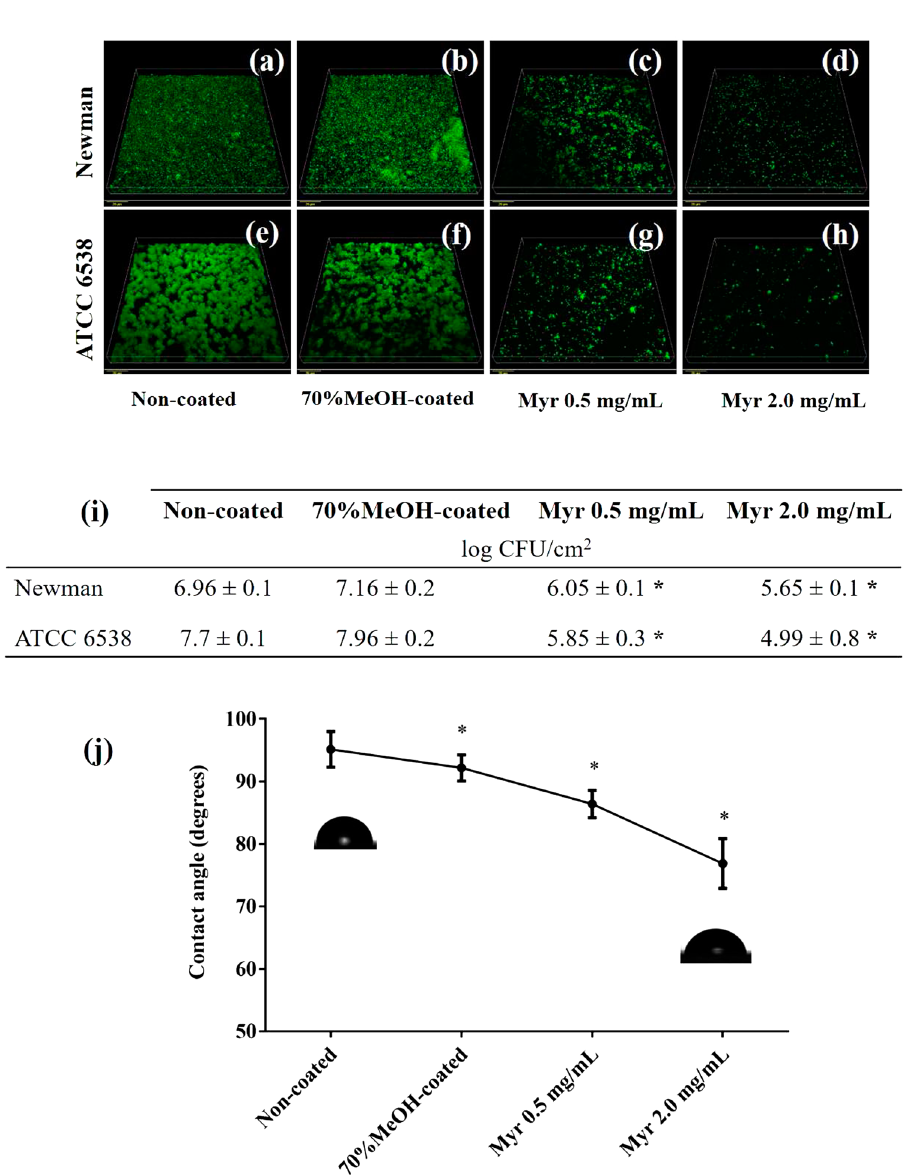
Figure 7. Effects of Myr when coated on a material surface. ( a–d ) Confocal images of S. aureus Newman biofilm formation on control surfaces and surfaces coated with Myr. ( e–h ) Confocal images of S. aureus ATCC 6538 biofilm formation on control surfaces and surfaces coated with Myr. Bars indicate 20 μ m. ( i ) Quantitative data of adhered cells on the surfaces. ( j ) Water contact angle of material surfaces. * Represents statistically significant difference ( p -value < 0.01) from the non-coated material. All of these methodologies can be found in Supplementary